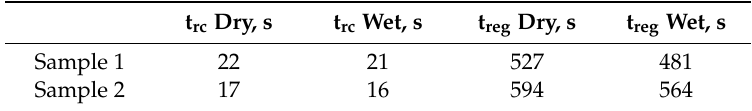
Table 4. The reaction and regeneration times (mixture of 0–1% of hydrogen in synthetic air), temperature 150 ◦ C ( ± 0.57